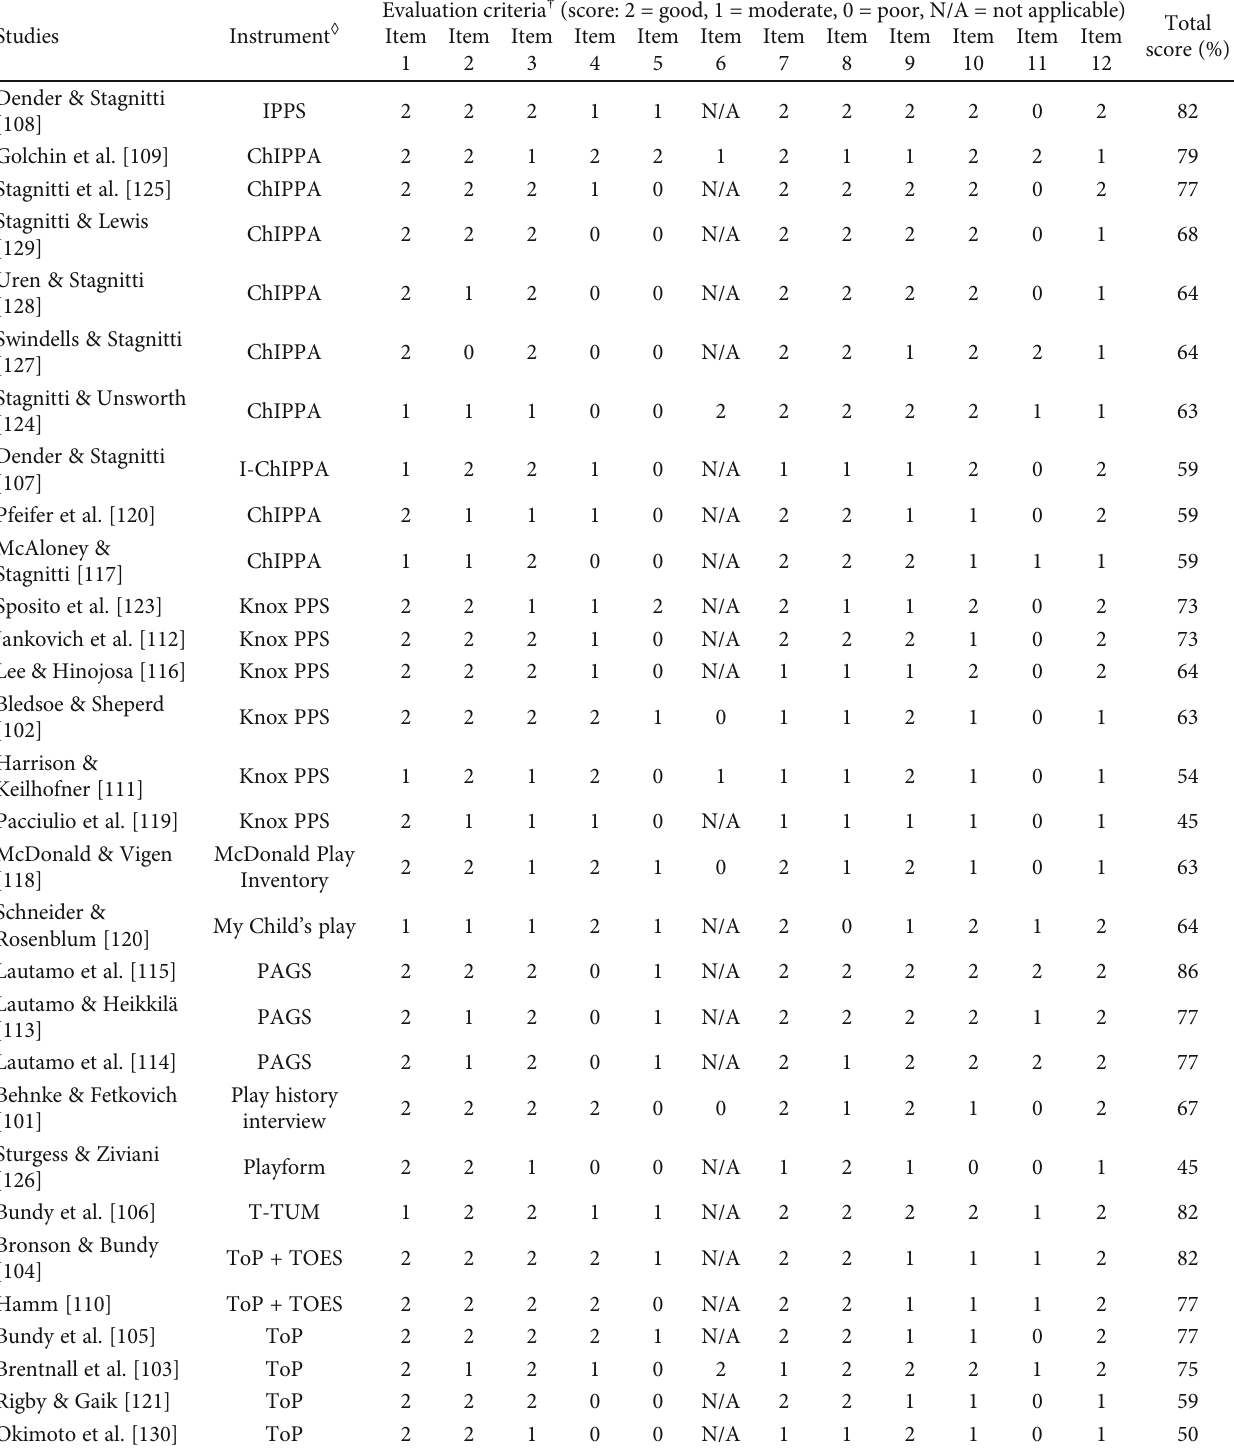
Table 2: Quality assessment on each included study using Law and MacDermid [24]